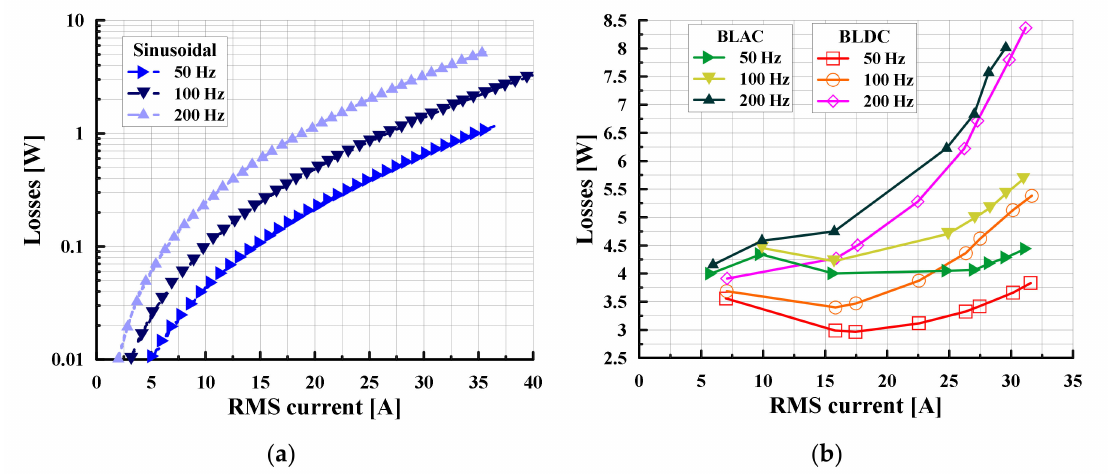
Figure 6. ( a ) Solitary coil losses at pure sine; ( b ) solitary coil losses modulated waveforms (BLAC, BLDC). For more clarity, on the Figure 7a,b, two periods of current are shown: BLDC and